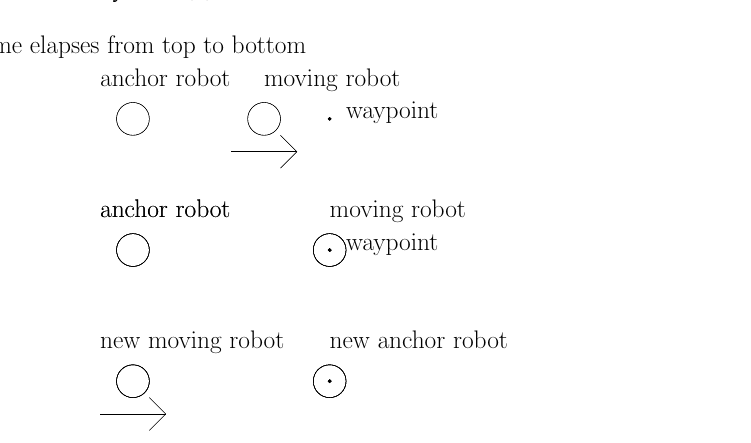
Figure 1. An illustration of the stop–go policy. Time elapses from top to bottom. The movement of a moving robot is plotted with an